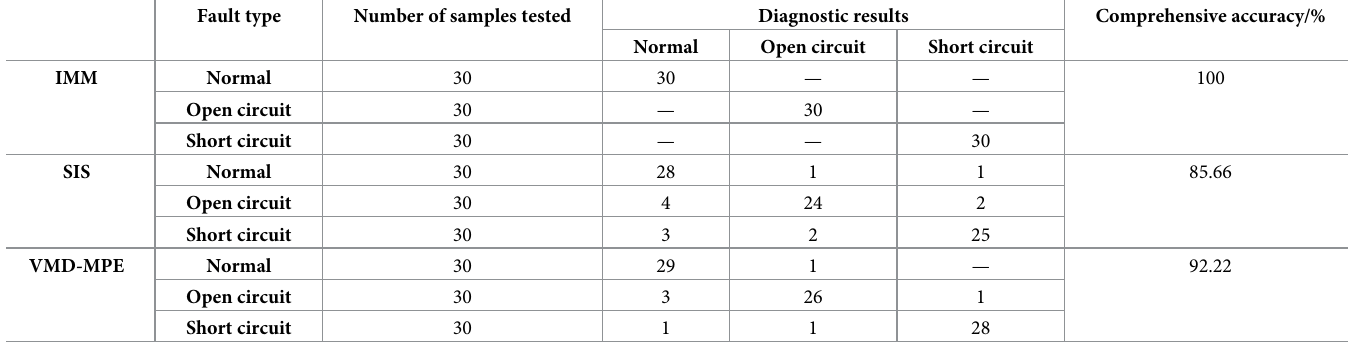
Table 13. Diagnostic results of each method. Fault type Number of samples tested Diagnostic results Comprehensive